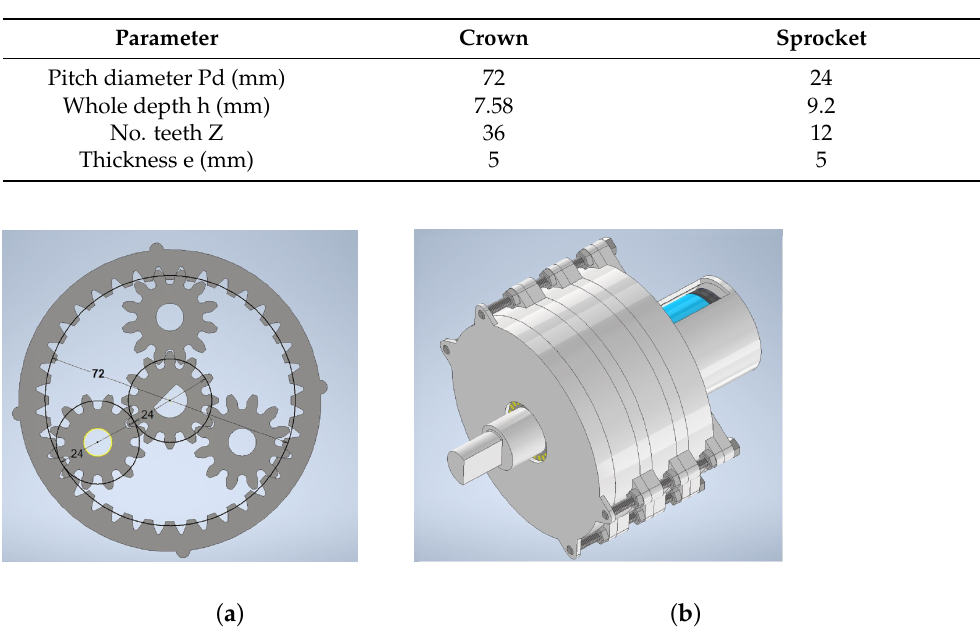
Table 5. Parameters for gearbox stage design.